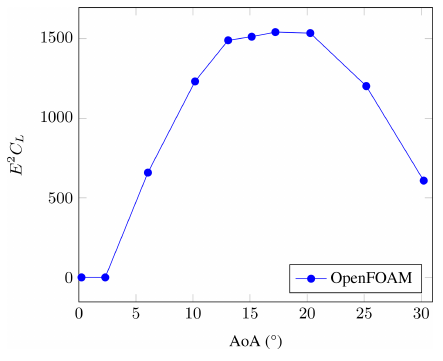
Figure 6. Performance of the baseline airfoil in terms of E 2 C L vs. AoA simulated in